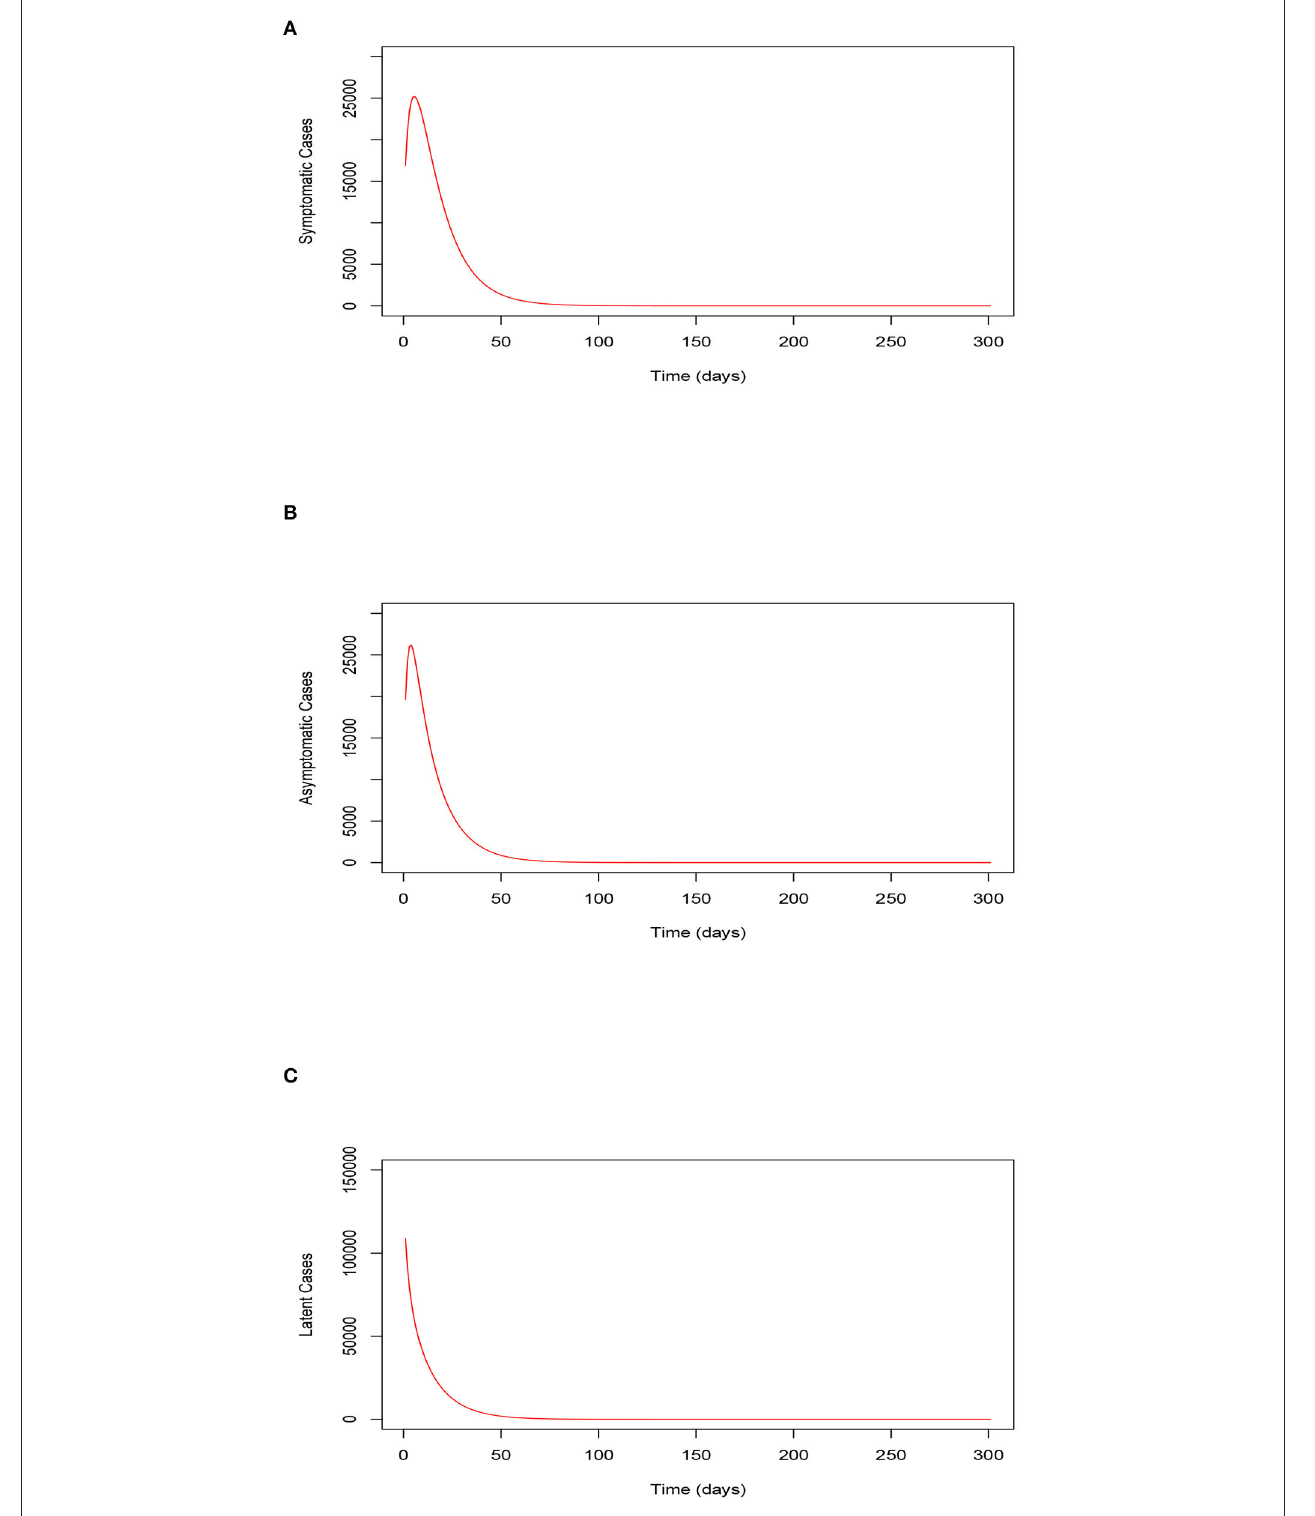
FIGURE 5 | (A) Trajectory of the symptomatic infections for the model (Equations 2–8) when the uptake of the COVID-19 vaccines and the use of face masks by the vaccinated is relatively high (80 % ). (B) Trajectory of the asymptomatic infections for the model (Equations 2–8) when the uptake of the COVID-19 vaccines and the use of face masks by the vaccinated is relatively high (80 % ). (C) Trajectory of the latent cases for the model (Equations 2–8) when the uptake of the COVID-19 vaccines and the use of face masks by the vaccinated is relatively high (80 % ). Trajectory of the symptomatic, asymptomatic, and latent classes of the model (Equations 2–8) when the uptake of the COVID-19 vaccines and the use of face masks by the vaccinated is relatively high (80 % ).